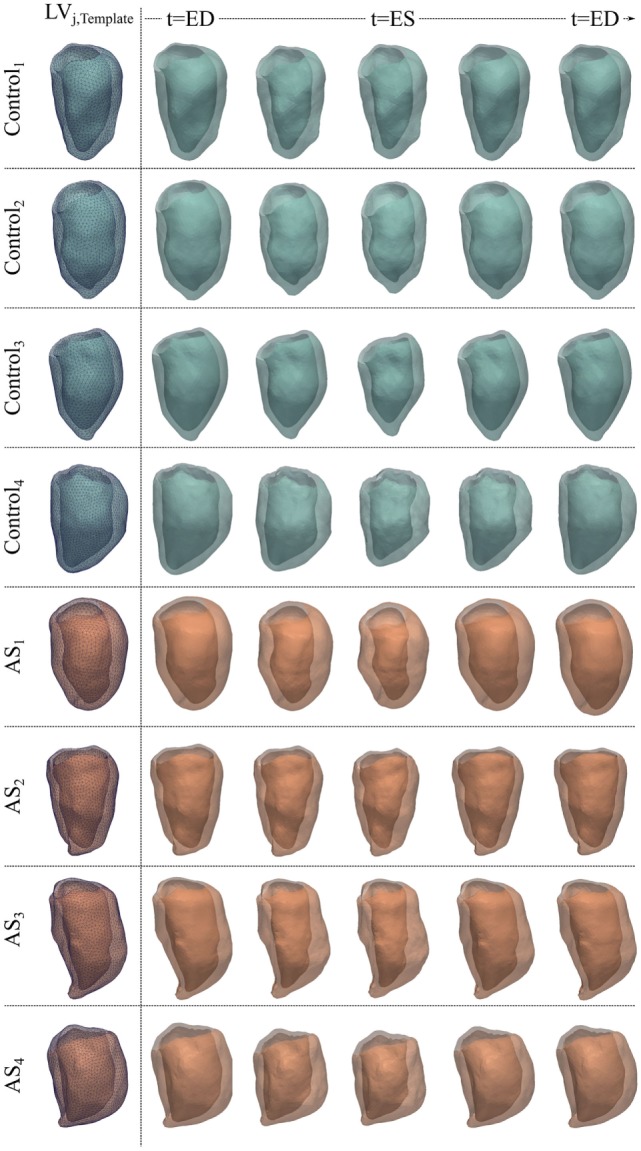
LVjt meshes for the 4 control and 4 AS subjects obtained by deforming subject-specific LVj,Template (first column) with the deformations estimated during the anatomical model computation, to reproduce 5 evenly spaced frames of the cardiac cycle illustrated in Figures 6 and 7 for each subject.